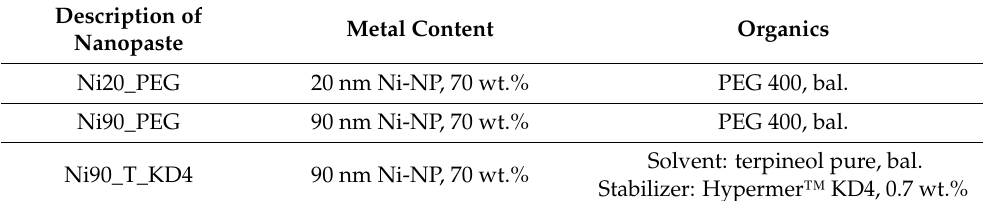
Table 2. Composition of the nanopastes. Description of Nanopaste Metal Content